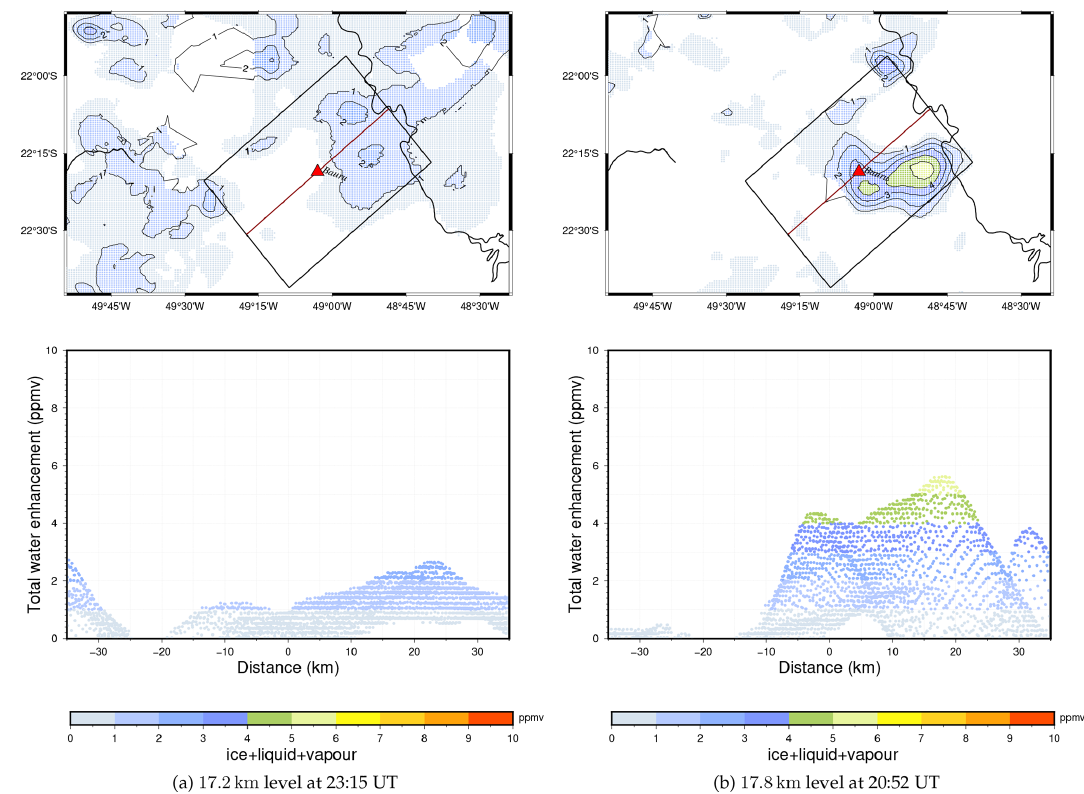
Figure 4. Like Fig. 3 but representing